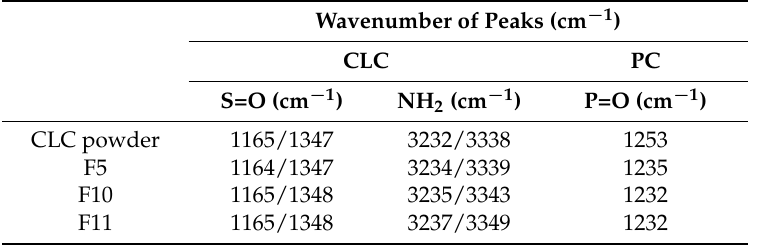
Table 3. Wavenumber of peaks for S=O asymmetric and symmetric stretching and N–H stretching vibration of CLC and P=O stretching of PC evaluated from CLC raw material powder, F5 (CLC + PC), F10 (CLC + PC + Neusilin ® US2), and F11 (CLC + PC + Neusilin ® US2 + CCS).